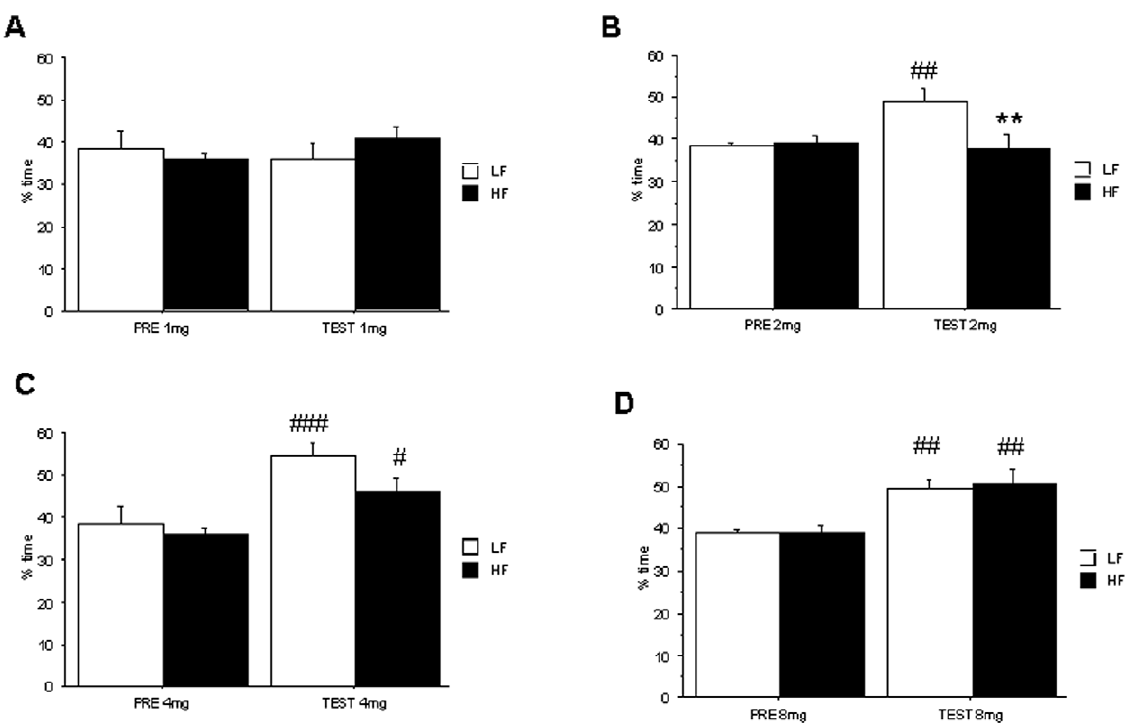
Figure 2. Conditioned-place preference induced by cocaine in control and HF C57BL/6J mice. CPP was induced by a three-day schedule treatment with 1 ( A ), 2 ( B ), 4 ( C ) or 8 mg/kg ( D ). Animals were tested during 30 min and results are expressed as % time spent in the white drug- paired arm. Values are mean 6 S.E.M of 7–8 animals (**p , 0.01 for comparison between control and HF groups, and # p , 0.05, ## p , 0.01, ### p , 0.001 for comparison between testing –TEST- and preconditioning –PRE- phases).